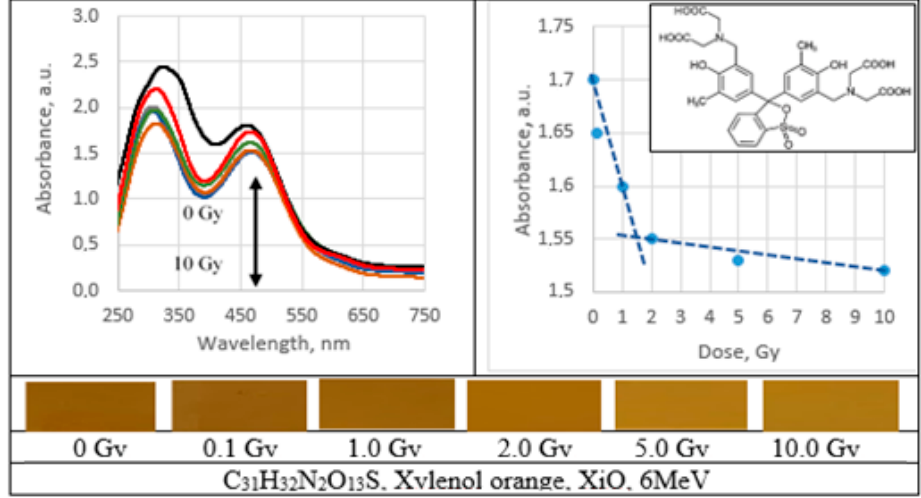
Figure 6. Absorbance spectra and sensitivity of the irradiated xylenol orange films.